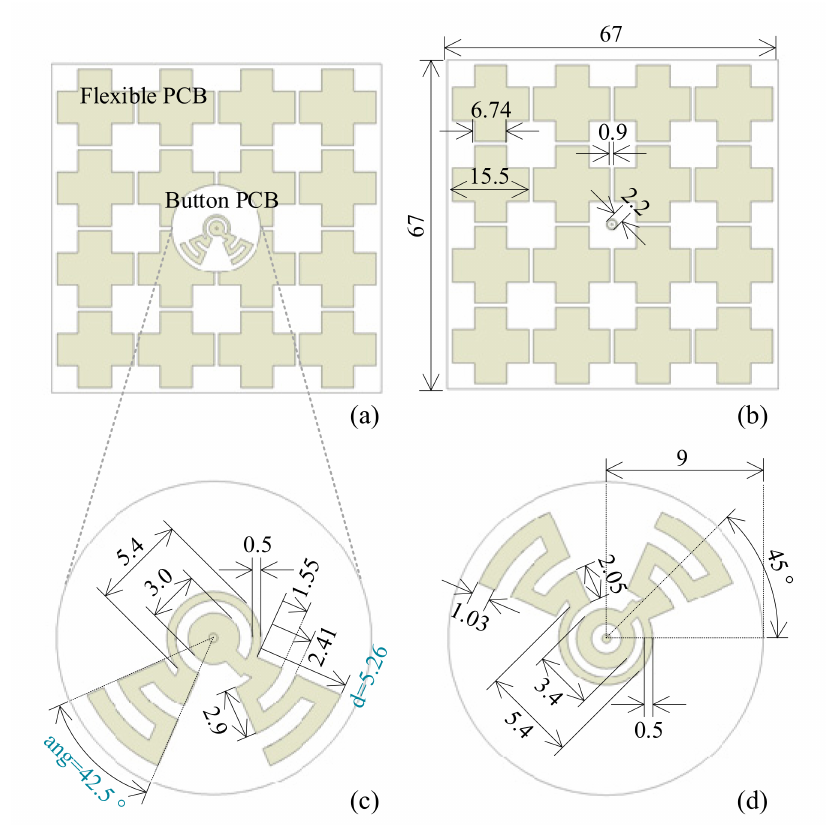
Figure 3. The topology of the proposed antenna sensor. ( a ) Top view of the proposed antenna sensor, ( b ) top view of the flexible PCB, ( c ) top view of the button PCB, and ( d ) bottom view of the button PCB. Dimensions are in mm.